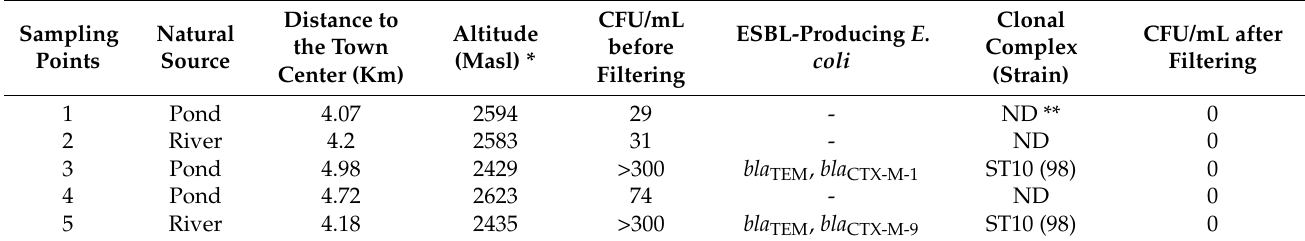
Table 2. Comparison of the microbiological characteristics of the water before and after the filtration with black ceramic water